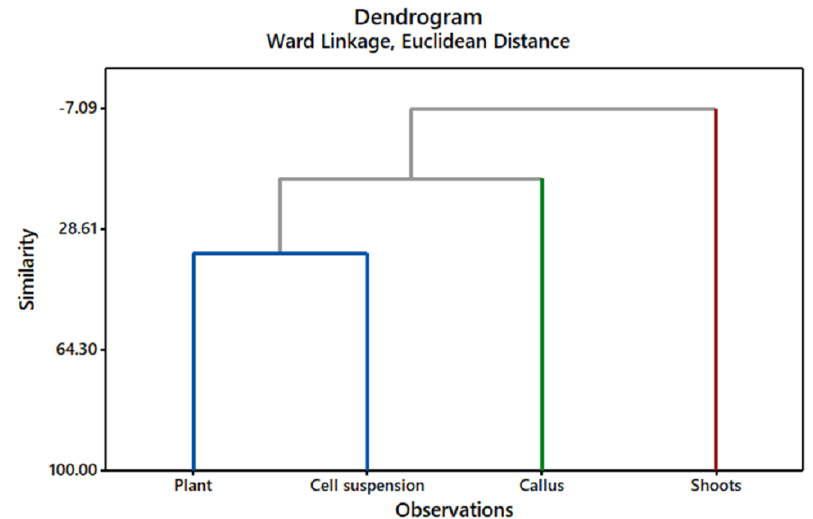
Figure 4. Dendrogram constructed using SSR data and Ward’s clustering method with Euclidean distance. The dendrogram shows genetic similarities between Gardenia plant, differentiated shoots and undifferentiated callus, and cell suspension cultures. Cultures having different genetic similarities were grouped in clusters with different colors (cluster 1—blue, cluster 2—green, and cluster 3 — red).